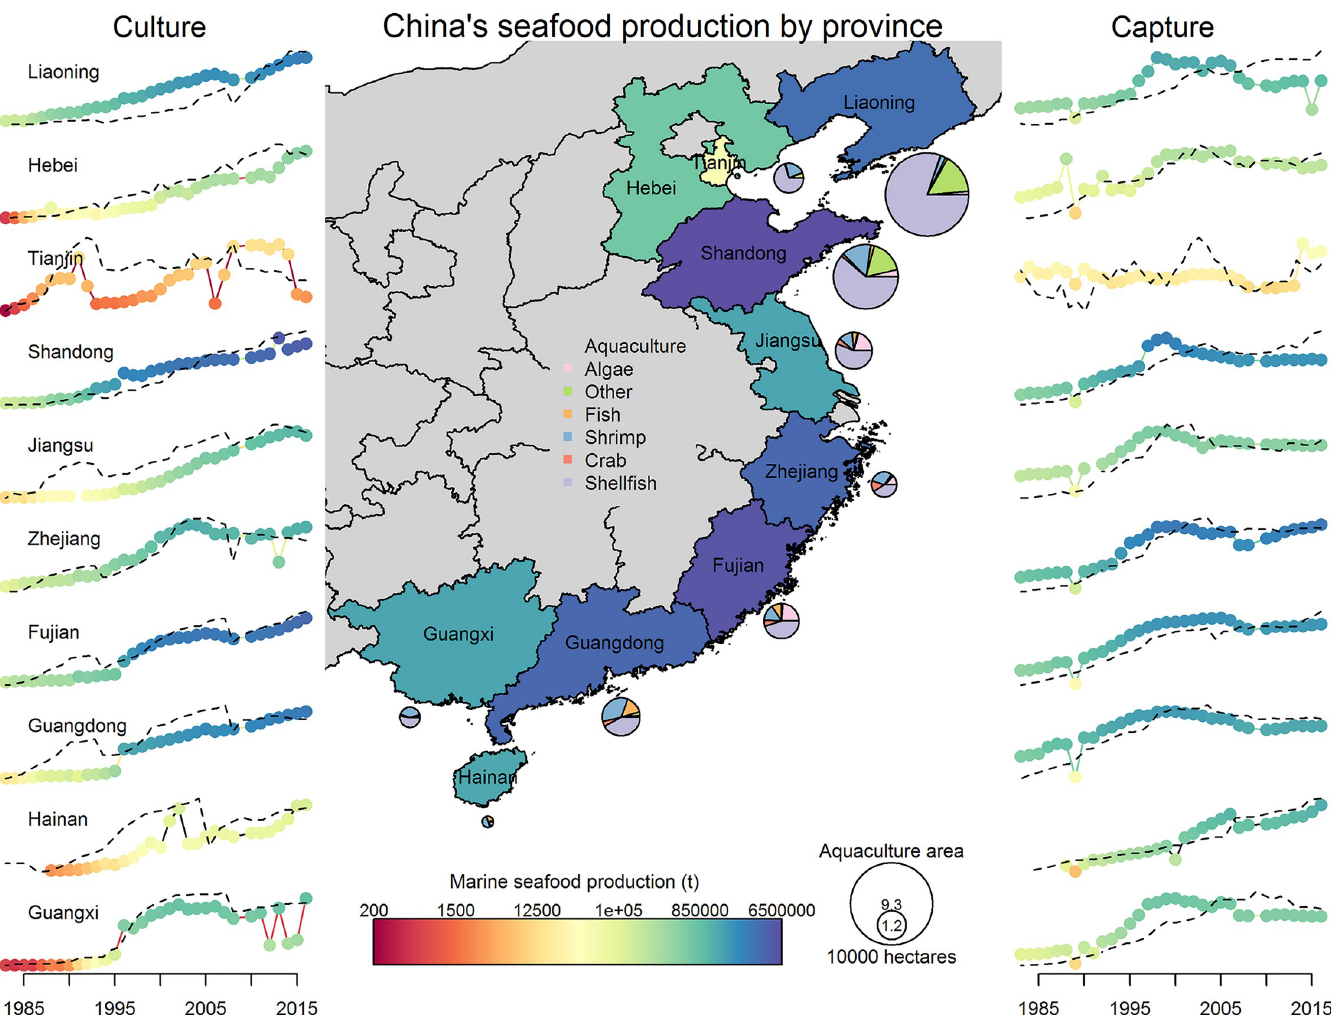
Fig 2. Total marine production of cultured (left) and captured (right) seafood over time by province. Data were not available for Chinese Taipei, so it was not included on the map. Dashed lines overlaid on culture and capture production by province represent the effort devoted to production (hectares and fleet power, respectively). Pie charts represent the relative size (not to scale) of area devoted to aquaculture in each province by product type. The magnitude of production by province is represented by color, with the scale indicated at the bottom of the figure.